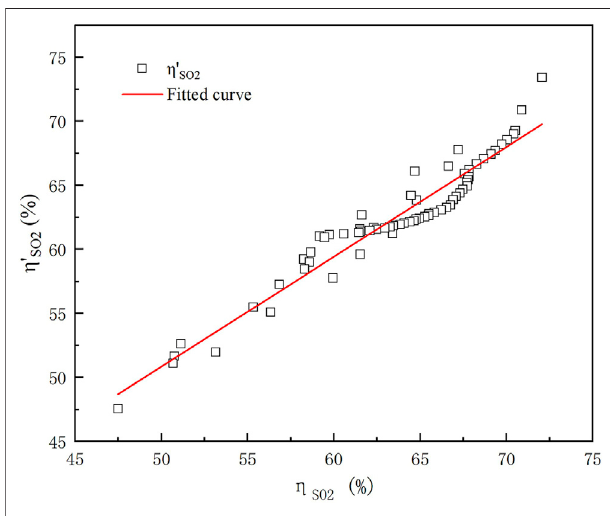
FIGURE 10 | Fitting model of the spray